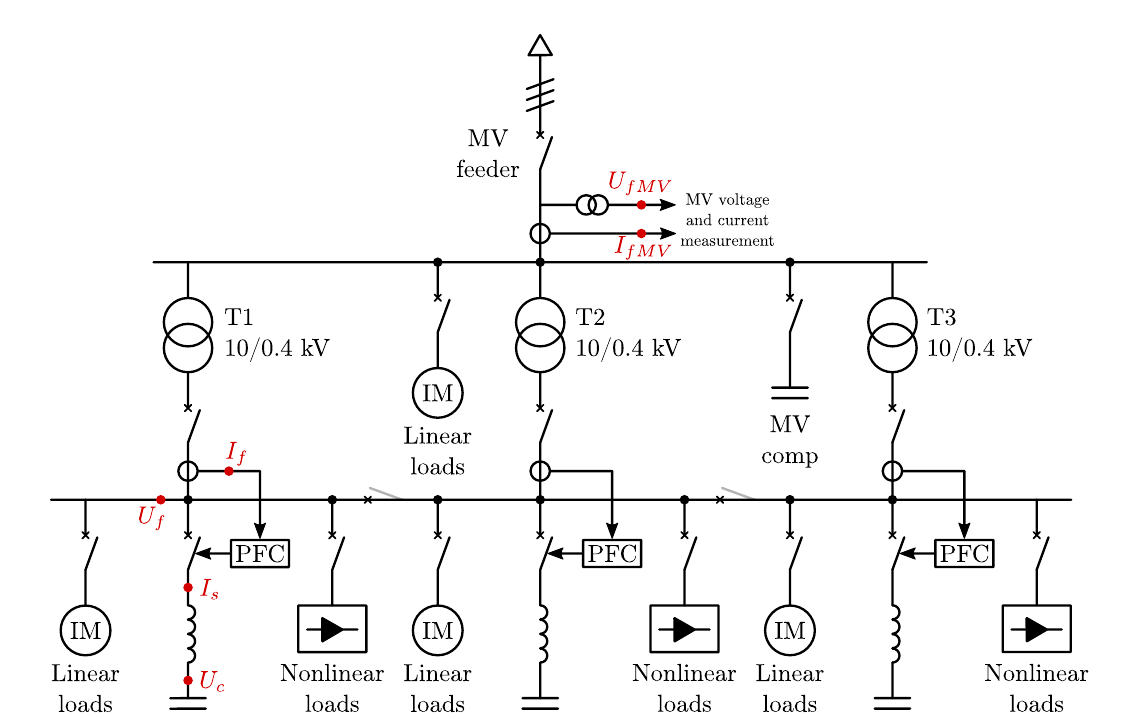
Figure 6. Single-line diagram of the transformer station with marked measurement points.